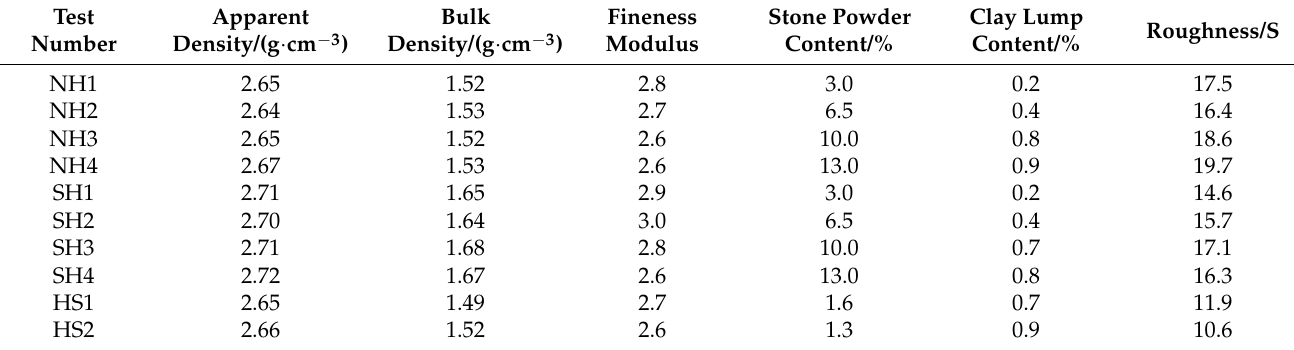
Table 5. Main performance indicators of fine